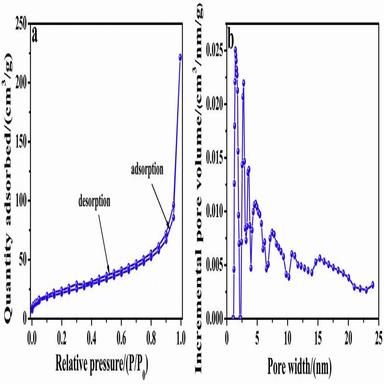
N2 adsorption-desorption isotherm (a) and pore size distribution (b) of Bi2O2CO3 microspheres.